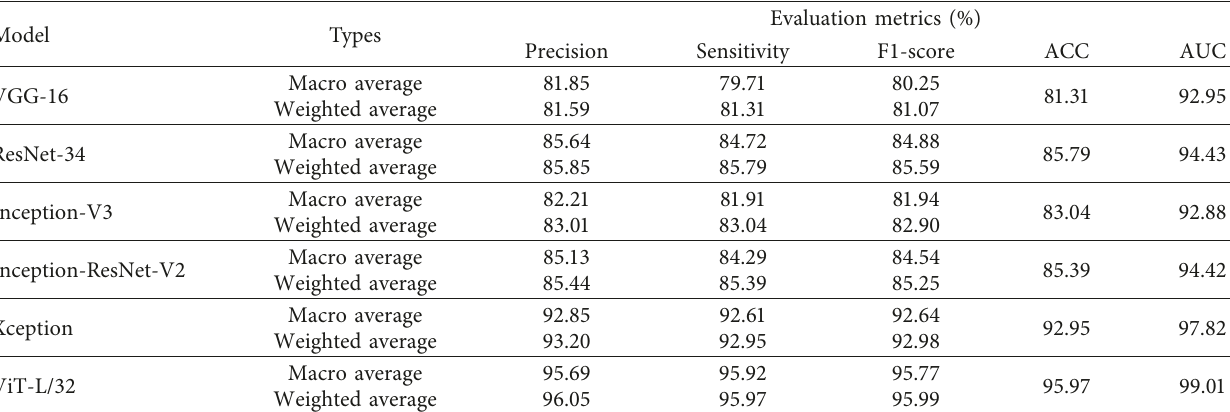
Figure 3: Examples of mushroom image augmentation: (a) original image, (b) random crop, (c) random rotation, (d) random horizontal flip, (e) random color jitter, (f) random blur, (g) random salt pepper noise, (h) random Gaussian Table 2: ViT-L/32 vs. SOTA CNN.